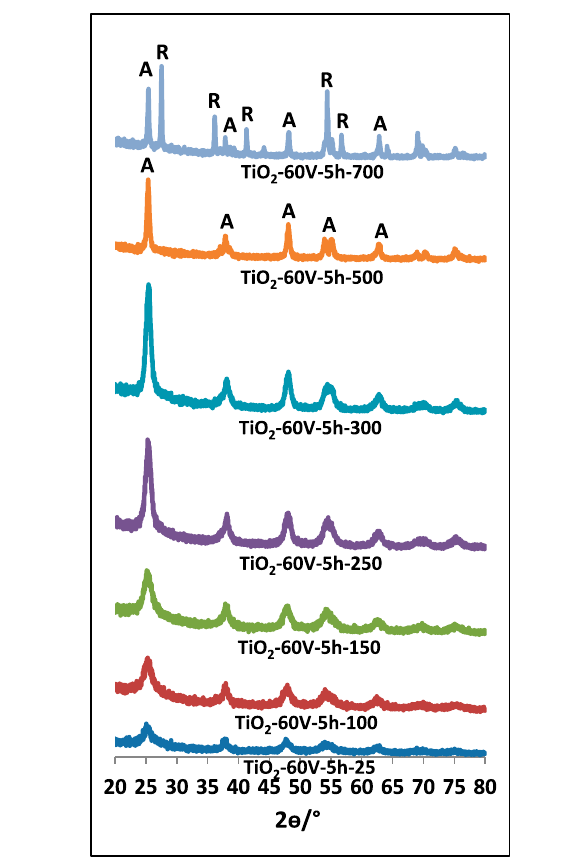
FIGURE 1 | XRD patterns of TiO 2 -60V-5h samples calcined at different temperatures.